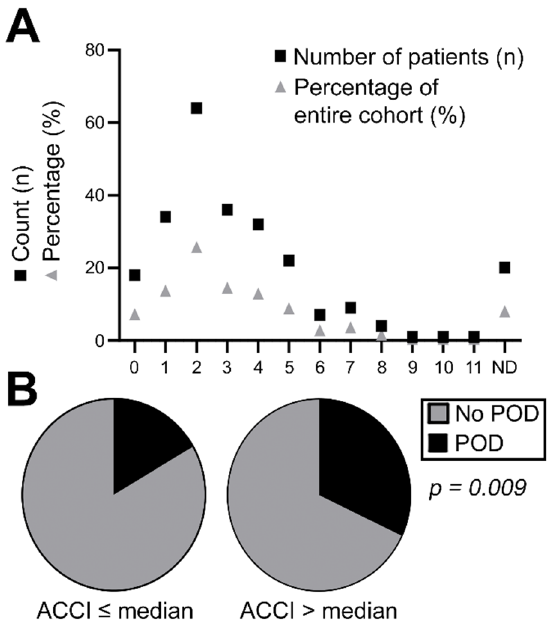
Figure 1. ( A ) Distribution of age-adjusted Charlson Comorbidity index with a mean of 3.0 points and a range between 0 and 11 points, ( B ) impact of age-adjusted Charlson Comorbidity index on incidence of POD. ND = not determinable. Table 1. Clinicopathological characteristics of the patient cohort a .